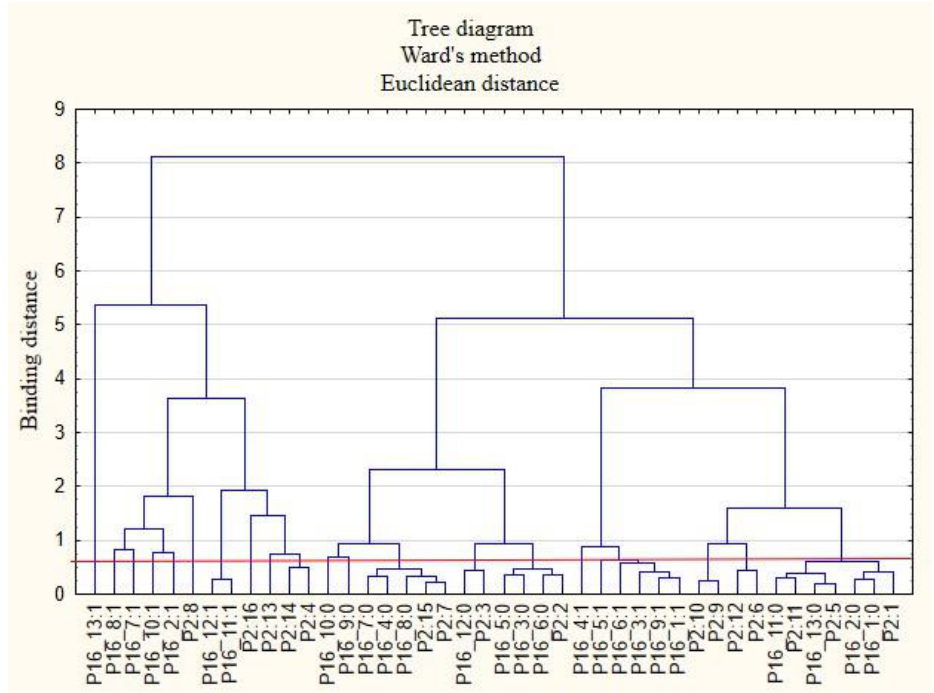
Figure 7. Diagram of hierarchical classification of variable categories: support that respondents want